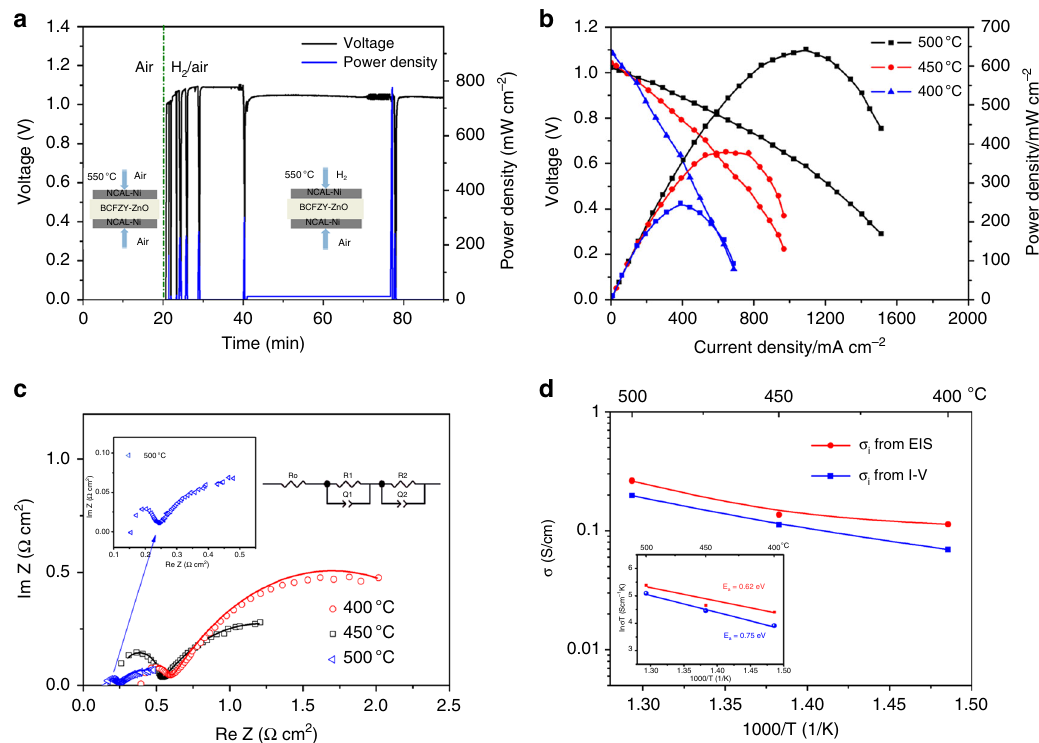
Fig. 2 Electrochemical performance and conductivity. a Activation process for 7 cycles of the BCFZY-ZnO electrolyte-based SOFC at 550 °C to achieve active voltage and current, ( b ) Electrochemical performance of the stabilized BCFZY-ZnO electrolyte based SOFC at 400 – 500 °C, ( c ) Impedance spectra of BCFZY-ZnO fuel cell measured in H 2 /air at 400, 450, and 500 °C, and the corresponding equivalent circuit model for fi tting, ( d ) Ionic conductivity and activation energy plots of BCFZY-ZnO as a function of 1000/T obtained from EIS and I-V curve at 400 – 500